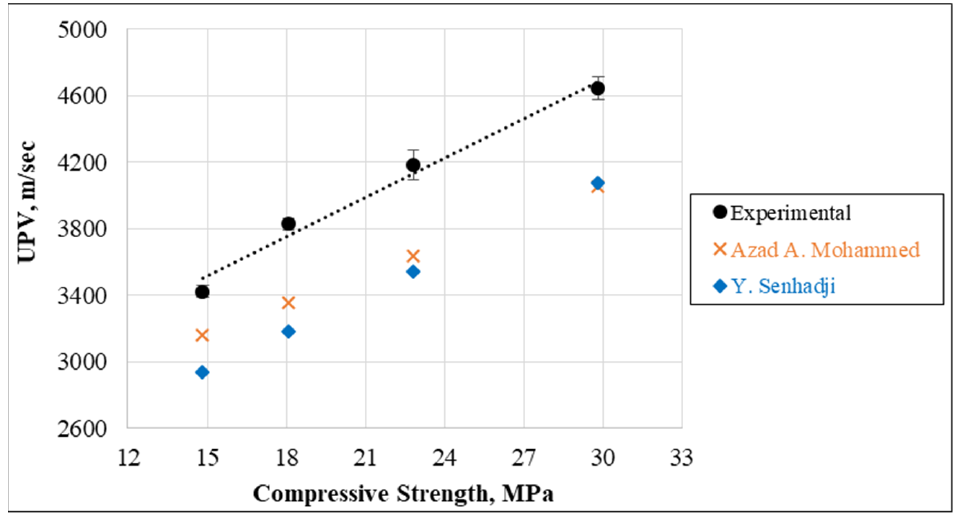
Figure 31. Relationship between UPV and compressive strengths [27,65].